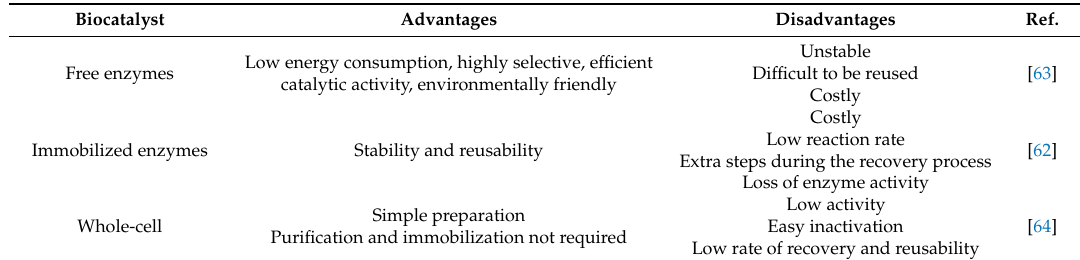
Table 5. Biocatalysis used in biodiesel